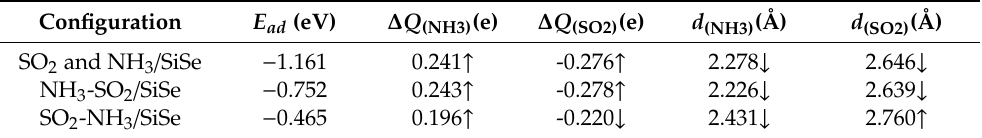
Table 5. Adsorptionenergy(E ad ),Mullikenchargetransfer( ∆ Q),andclosestdistance(d)oftheNH 3 molecule and the SO 2 molecule, respectively in SO 2 and NH 3 / SiSe, NH 3 -SO 2 / SiSe, and SO 2 -NH 3 / SiSe configurations.